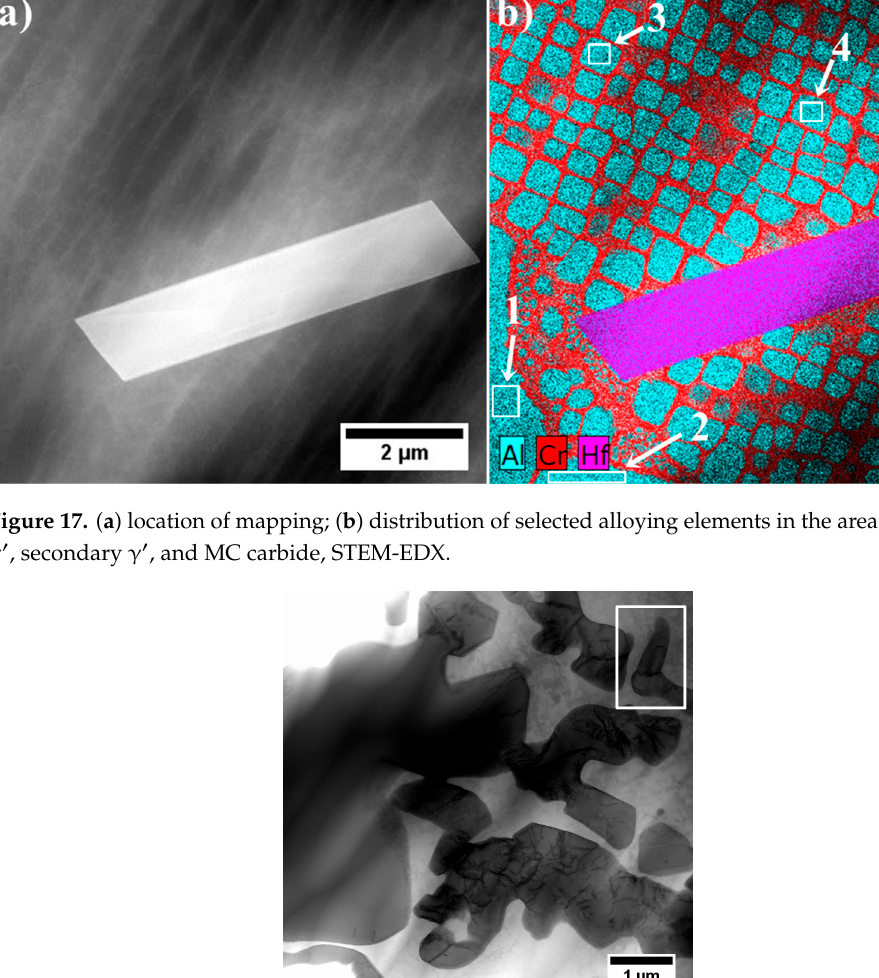
Figure 17. a ) location of mapping; b ) distribution of selected alloying elements in the area of primary γ ', secondary γ ', and MC carbide, STEM-EDX. Table 6. Chemical composition of the primary and secondary γ ' precipitates in interdendritic space, STEM-EDX, at%.